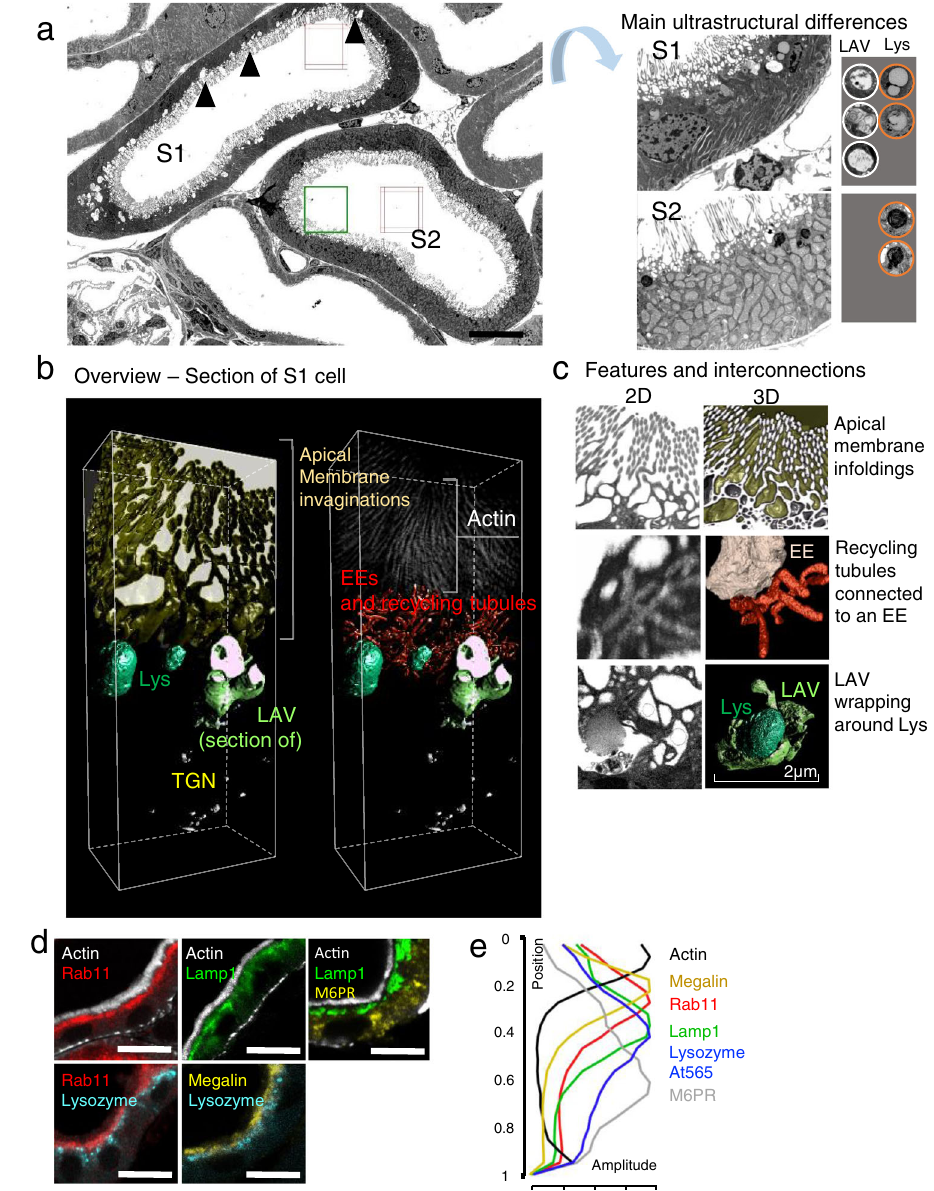
Fig. 4 | Three-dimensional reconstruction of the S1 endo-lysosomal system. a 2-D electron microscopy (EM) overview images of S1 and S2 segments of the proximal tubule, from stitched tile sets (boxes), showing large apical vacuoles (LAVs, arrowheads) only in S1. Lysosomes (Lys, orange circles) are more homo- geneousthanLAVsandappearelectrondenseinS2.Images acquired fromasingle animals. Scale bar: 10 μ m. b , c Reconstruction of the S1 endo-lysosomal system (ELS) in 3-D with FIB-SEM allowed segmentation of different structures (denoted with colors). Deep invaginations of the apical membrane (gold volume) bring the primary urine into close proximity to early endosomes (EEs). Recycling tubules exist in a network between EEs/LAVs and the apical surface. LAVs have a complex, irregular structure, whereas adjacent lysosomes are smaller and more spherical.